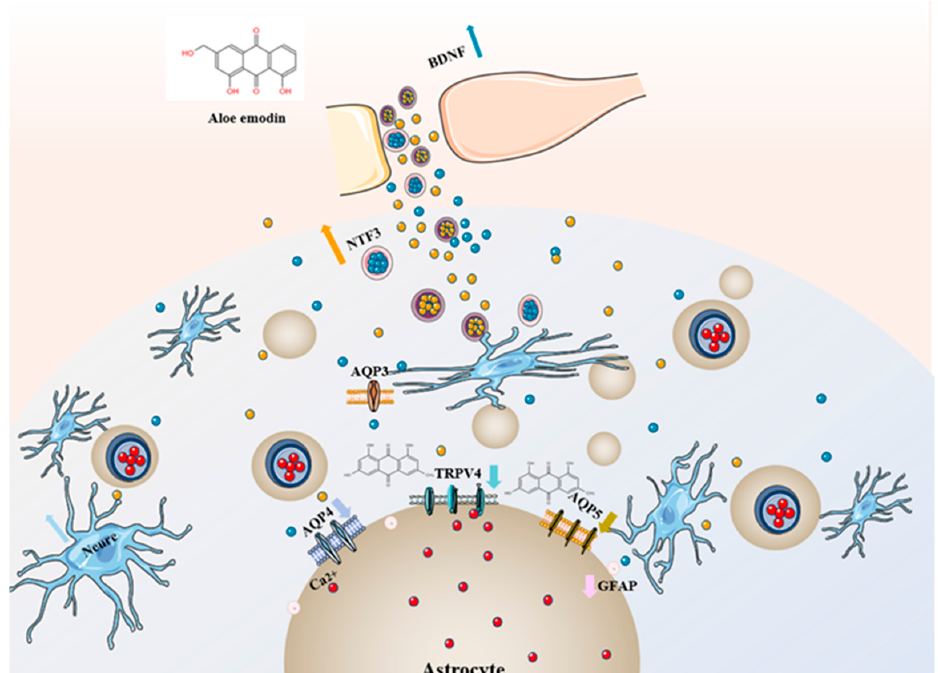
Figure 5. Mechanism of action of aloe emodin.